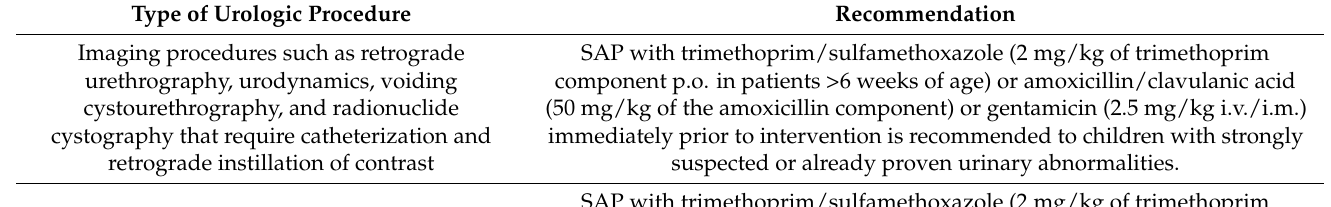
Type of Urologic Procedure